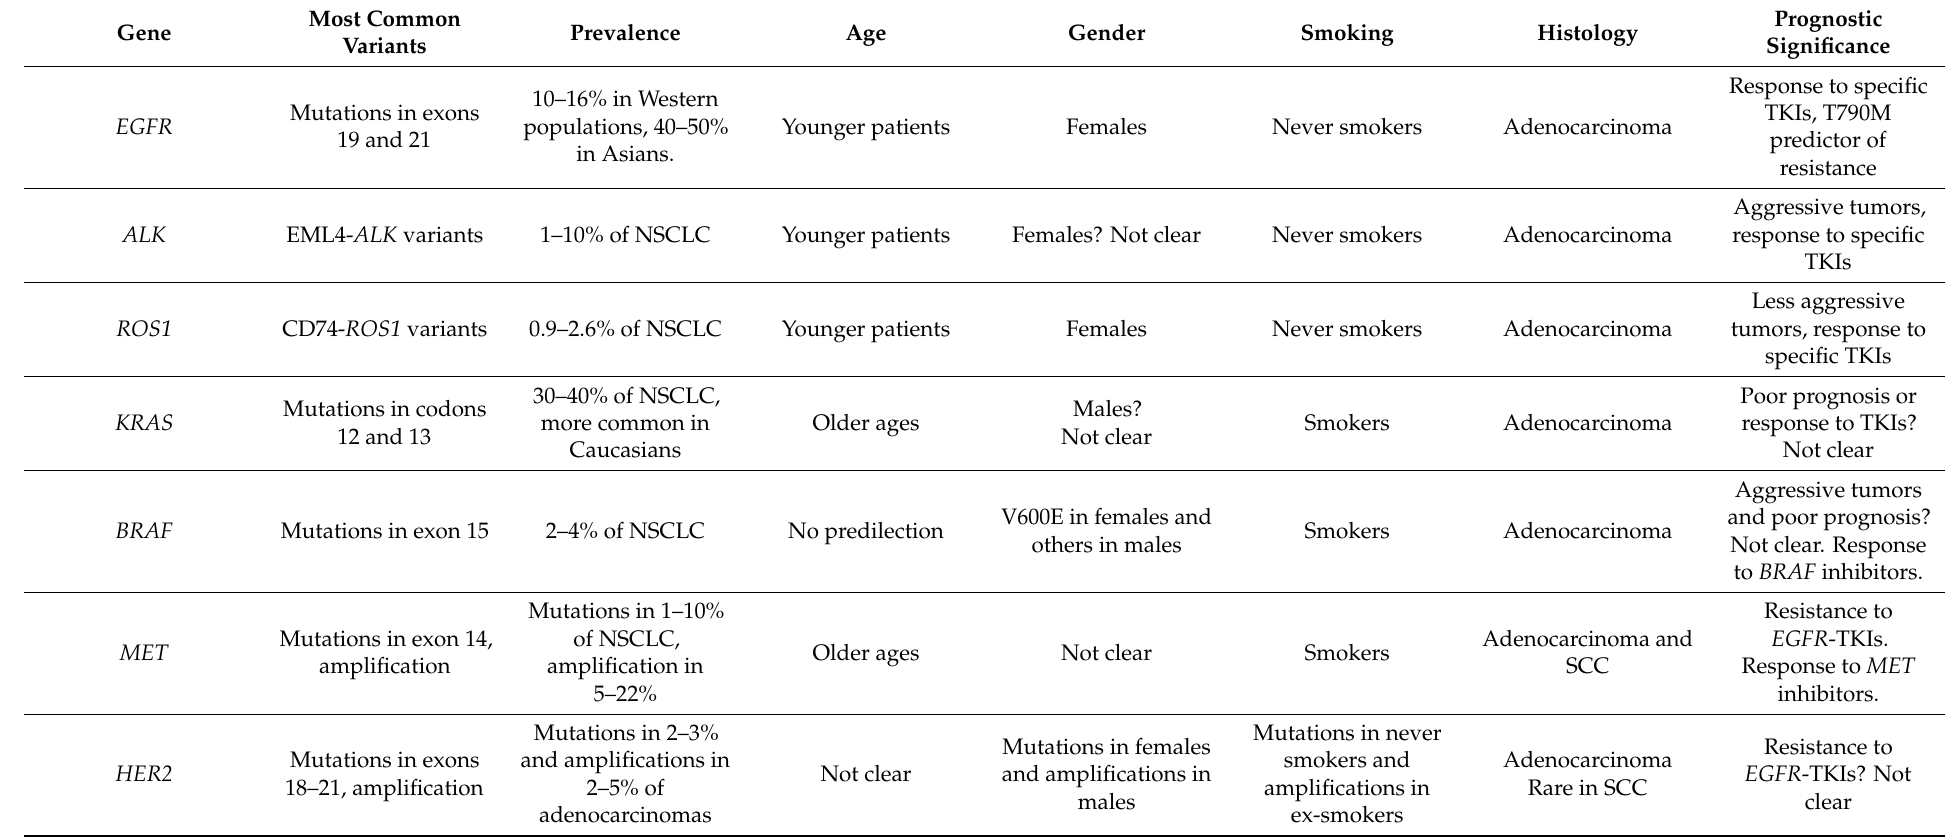
Table 1. Main epidemiological features of molecular alterations in main candidate genes in non-small cell lung